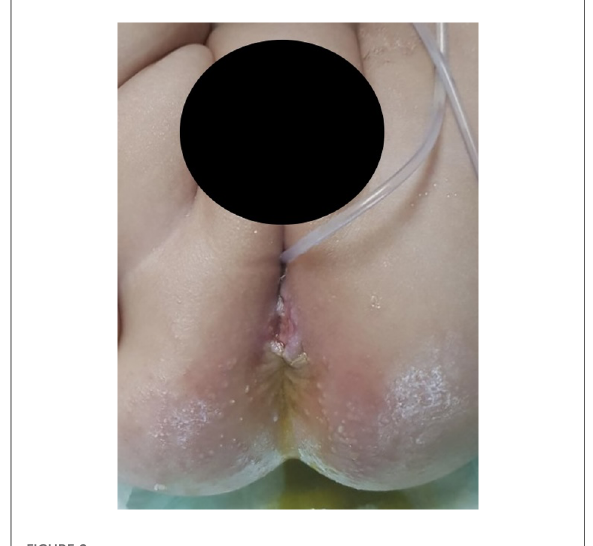
FIGURE 2 Super fi cial perineal wound infection.